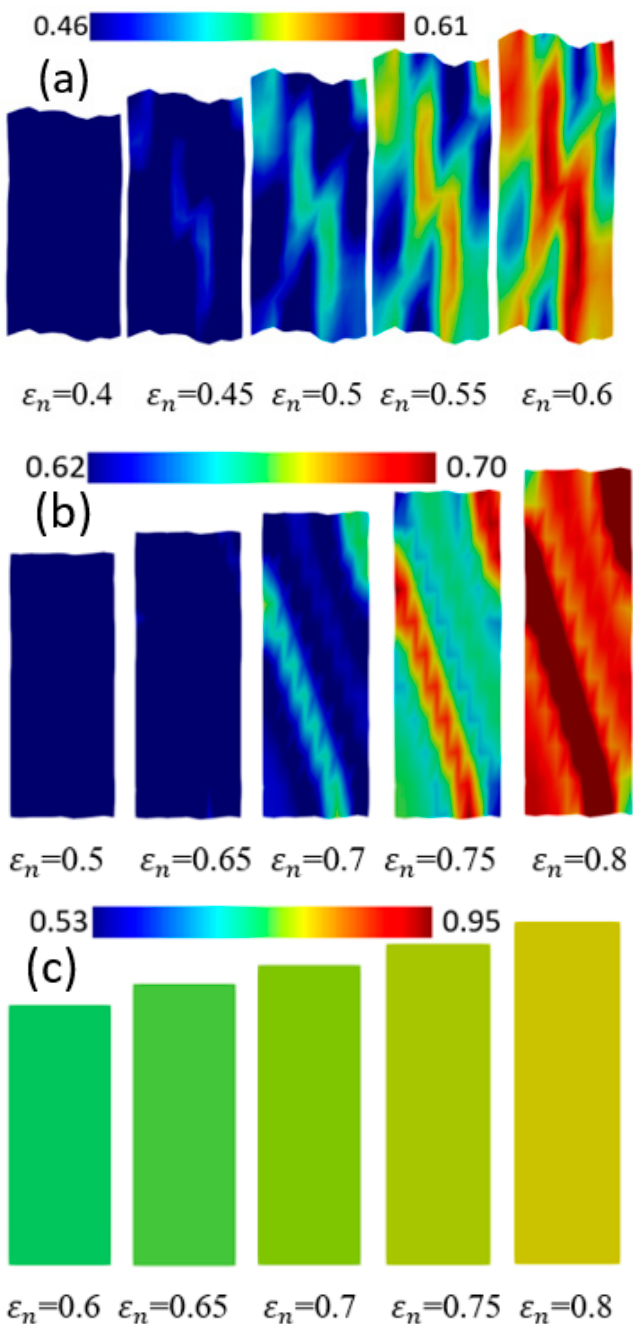
Figure 7. The distribution of martensitic phase of single crystal TRIP steel with initial crystallo- graphic orientations of ( a ) ∅ = 30 ° , ( b ) ∅ = 60 ° and ( c ) ∅ = 90 ° .